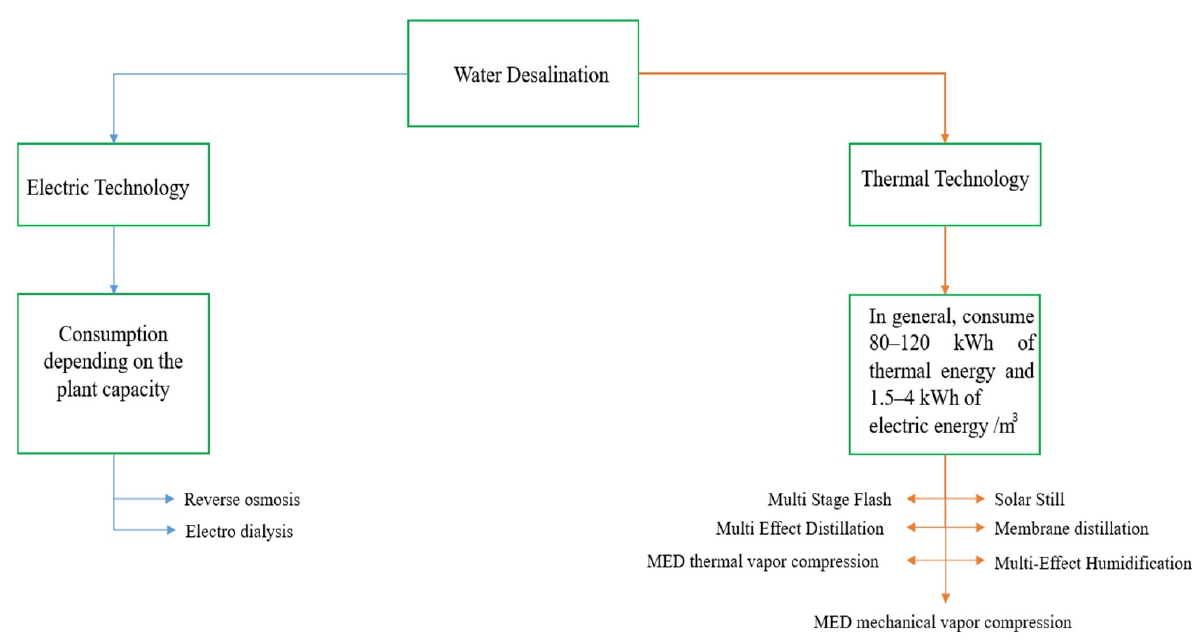
Figure 1. Flow chart diagram illustrating the available water desalination technologies.